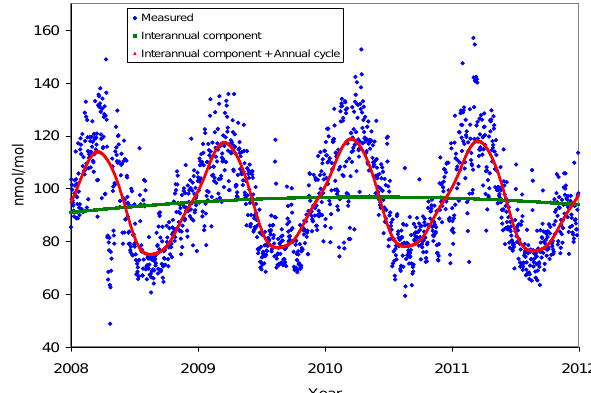
Fig. 4. Daily nighttime (20:00–08:00UTC) mean CO mole frac- tions measured at Iza˜na Observatory (blue squares). The interan- nual component and the annual cycle from Eq. (26) are shown as the green and red lines,